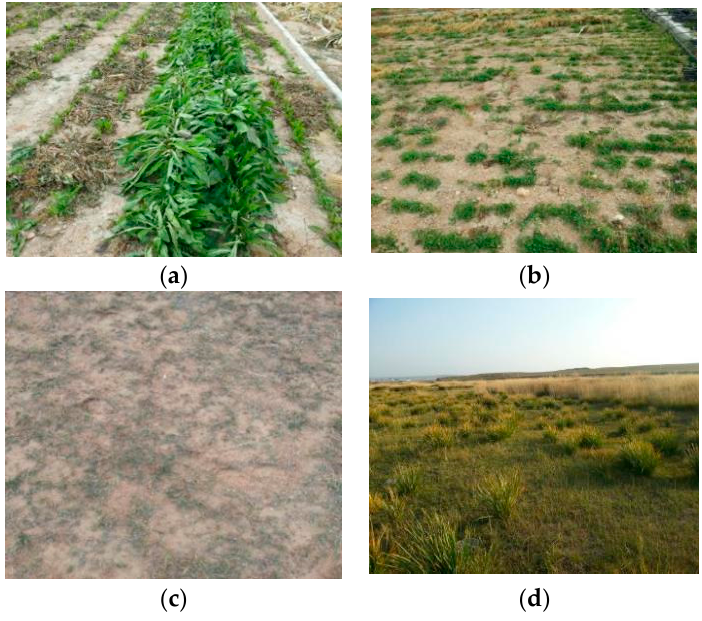
Figure 7. Vegetables ( a ), alfalfa ( b ), natural grassland ( c ), washland ( d ). Table 1. Soil moisture of four different land cover types and two plots obtained by ground wave and reflected wave.